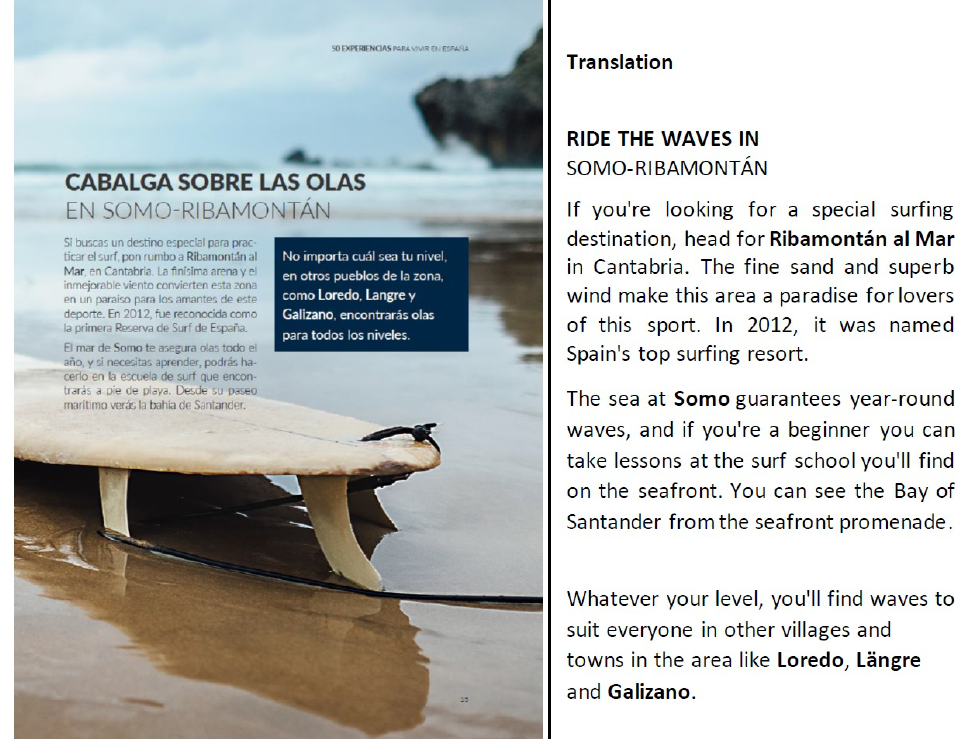
Figure 5. Example poster that was used in the study and the translation (in a separate box for showcase